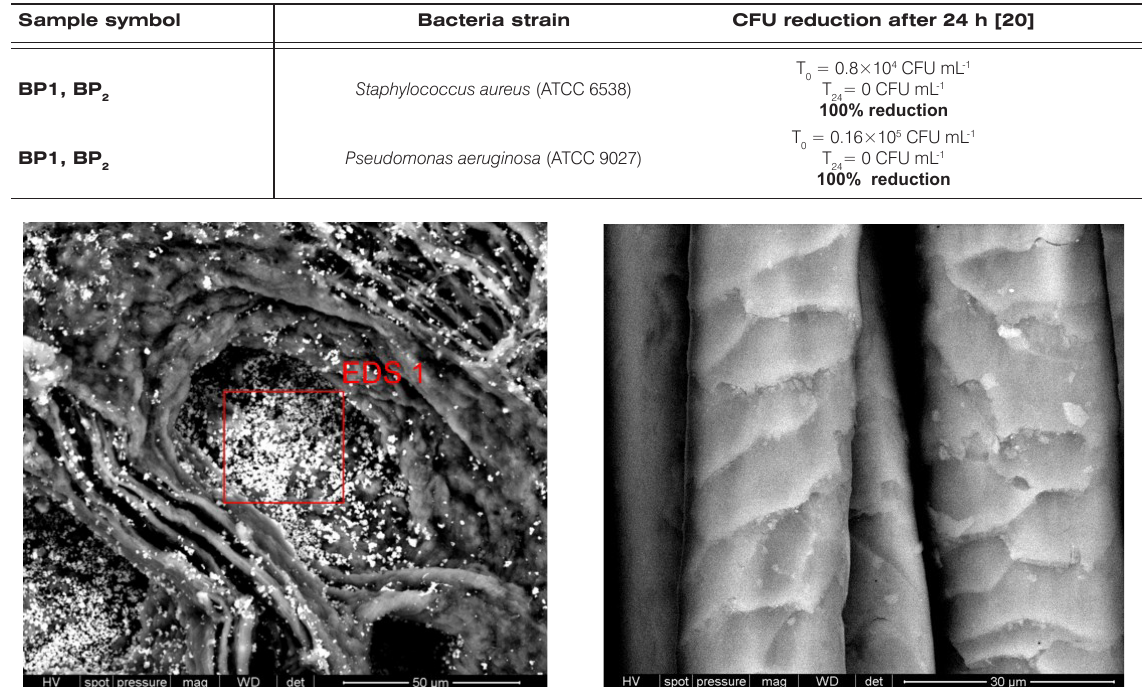
Figure 6. SEM image of AgNPs deposited onto collagen fibrillar structure of dermal layer of sheepskin